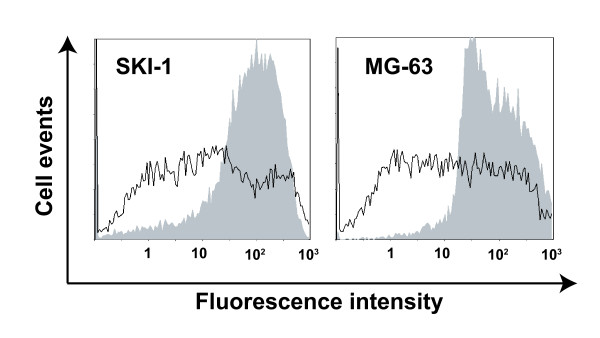
Dye transfer in multicellular spheroids. The transfer of calcein was measured in SKI-1 and MG-63 spheroids in absence (grey area) or presence (black line) of AGA. The plot presented for each cell line is representative of an experiment performed three times.